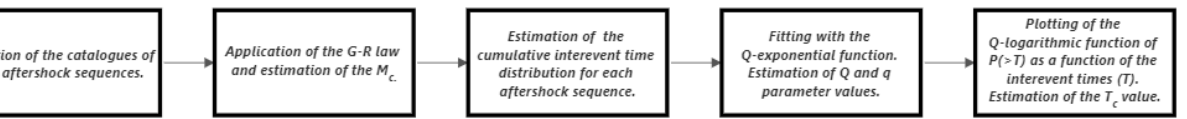
Table 1. Results of all analyzed aftershock sequences, where M c is the completeness magnitude of the catalogue used, q is the Tsallis entropic parameter of the interevent time distribution, T q denotes the generalized scaled interevent time, and T c is the cross-over point at which the transition from Tsallis to BG statistical mechanics occurs.